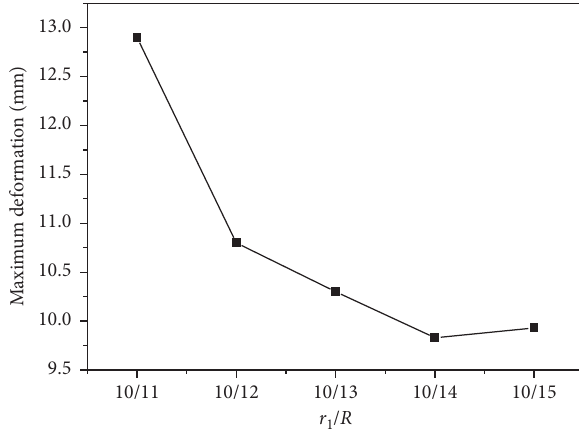
Figure 7: Deformation curves with different distances between two adjacent